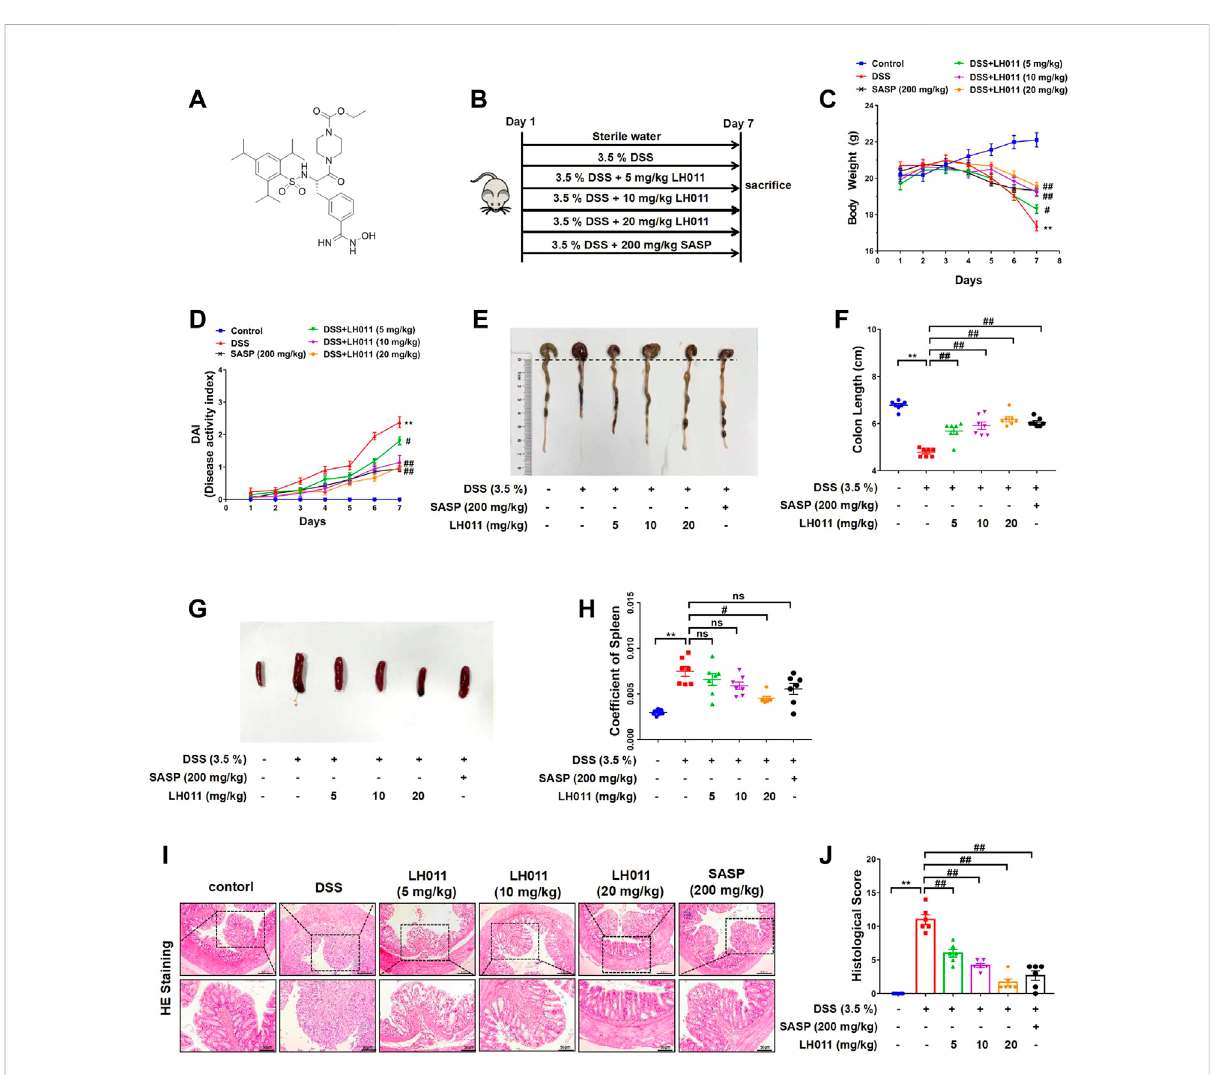
FIGURE 1 LH011 improved DSS-induced colitis in mice. (A) Chemical structure of LH011. (B) Diagram of animal experimental fl ow process. (C) Body weight changes. n = 9. (D) Disease activity index (DAI) scores n = 7. (E) Representative images of colons were shown. (F) Length of colons was measured and analyzed. n = 7. (G) Representative images of the spleen. (H) Coeff fi cent of the spleen in each group. n = 7. (I) Histological changes weredetectedbyH&Estaining,scalebar:200 μ mn=6. (J) HistologicalscoresofH&Eineachgroup.n=6.Alldataarepresentedasthemean± SEM. ** p < 0.01 vs. control group; # p < 0.05, ## p < 0.01 vs. DSS group; ns, no signi fi